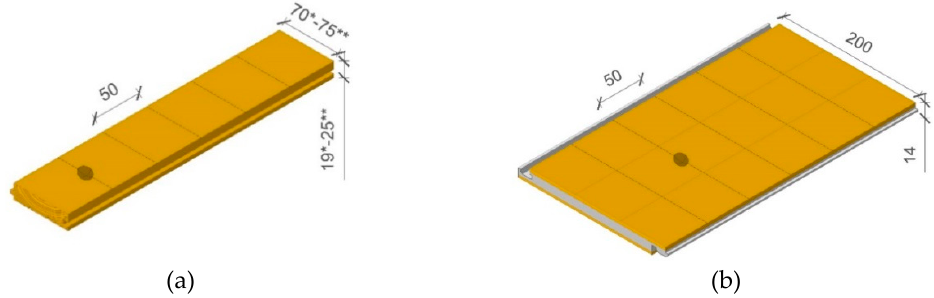
Figure 1. Impact test specimens ( a ) solid wood flooring ( b ) engineered wood flooring.